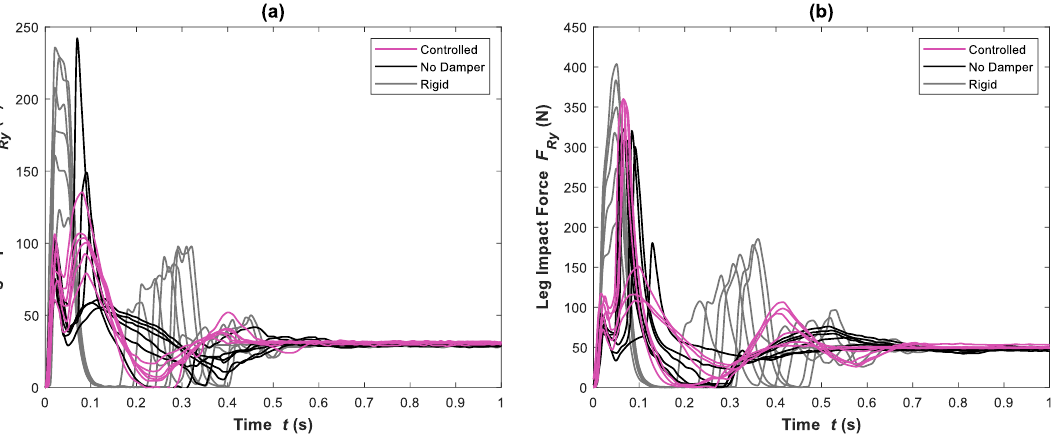
Figure 11. Controlled impact force for impact tests at all drop heights with total masses of ( a ) 2.65 kg and ( b ) 4.60 kg.